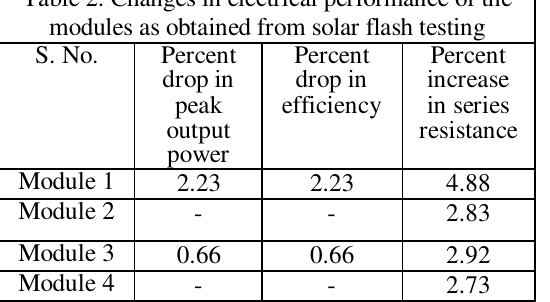
Table 2: Changes in electrical performance of the modules as obtained from solar flash testing S.